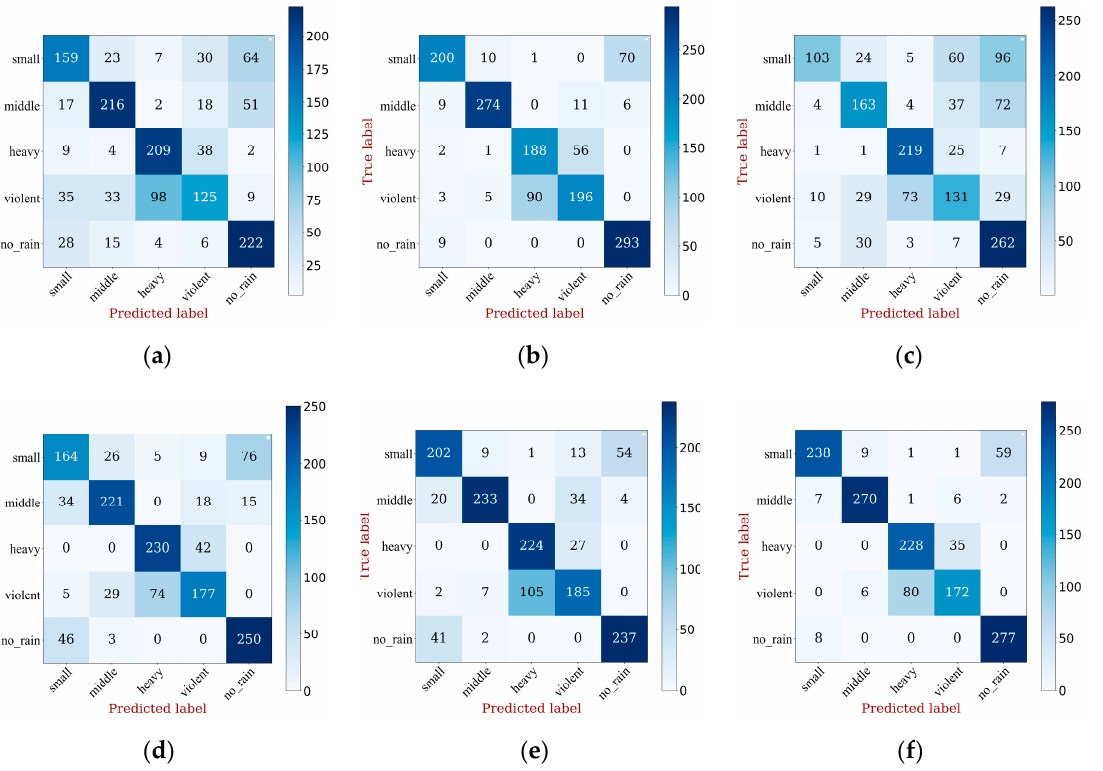
Table 4. Comparison of PPMCC with different features.